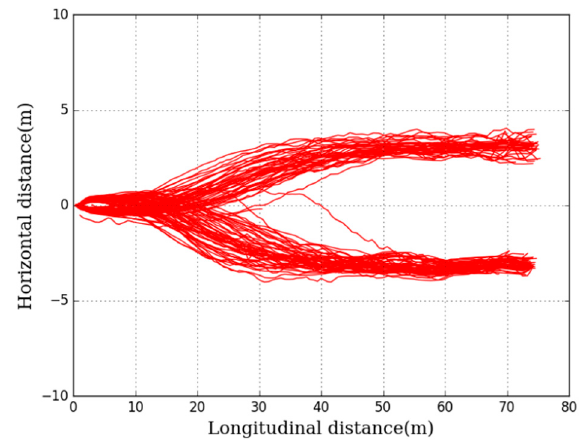
Figure 4. Lane changes.